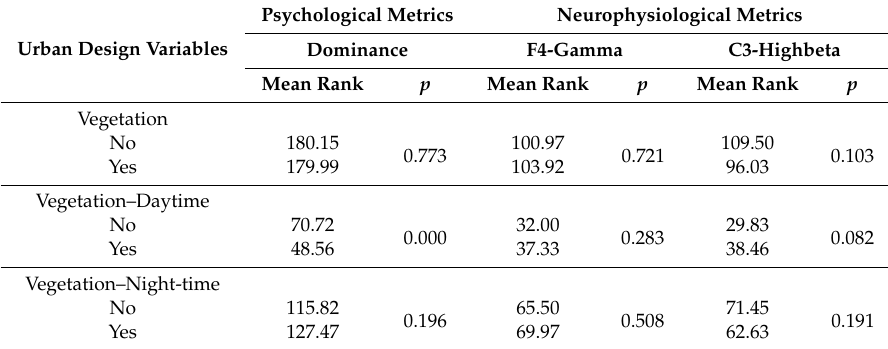
Table 4. Mann–Whitney U tests for the di ff erences in the mean ranks of the psychological and neurophysiological metrics in the absence and presence of vegetation (significance level p < 0.05).